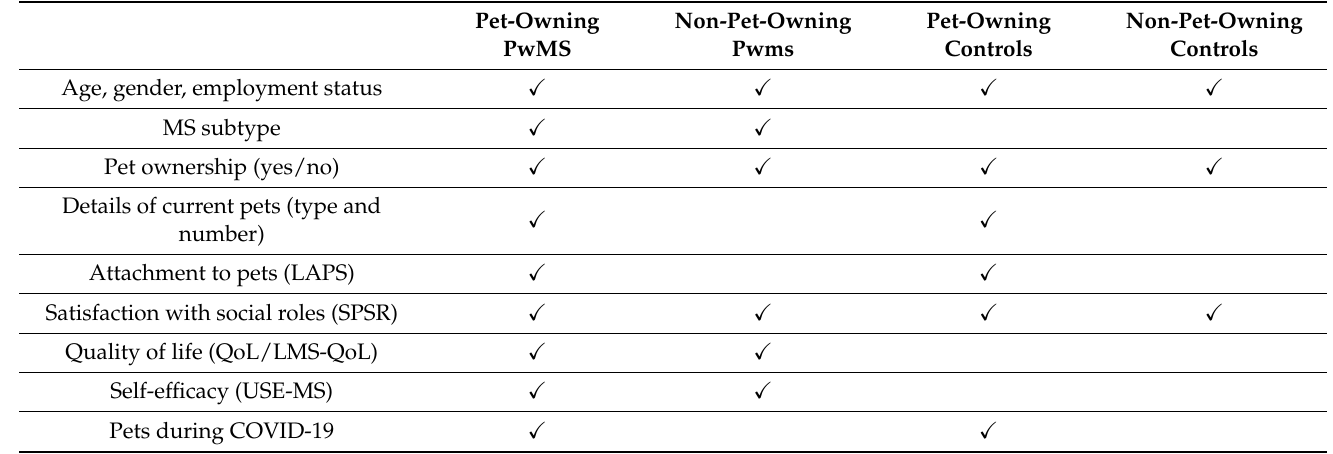
Table 1. Information collected from participant